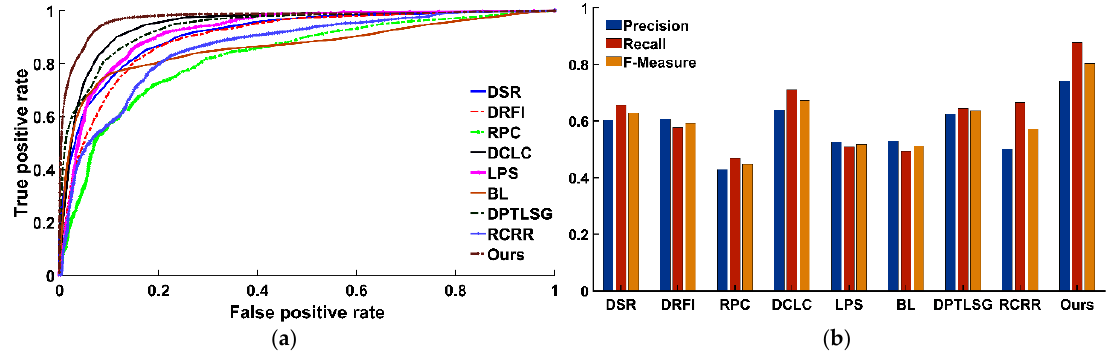
Figure 5. Quantitative evaluation results of different methods: ( a ) ROC curves of different methods on Sentinel-2 images ( b ) Precision, recall, and F-measure of different methods on Sentinel-2 images.